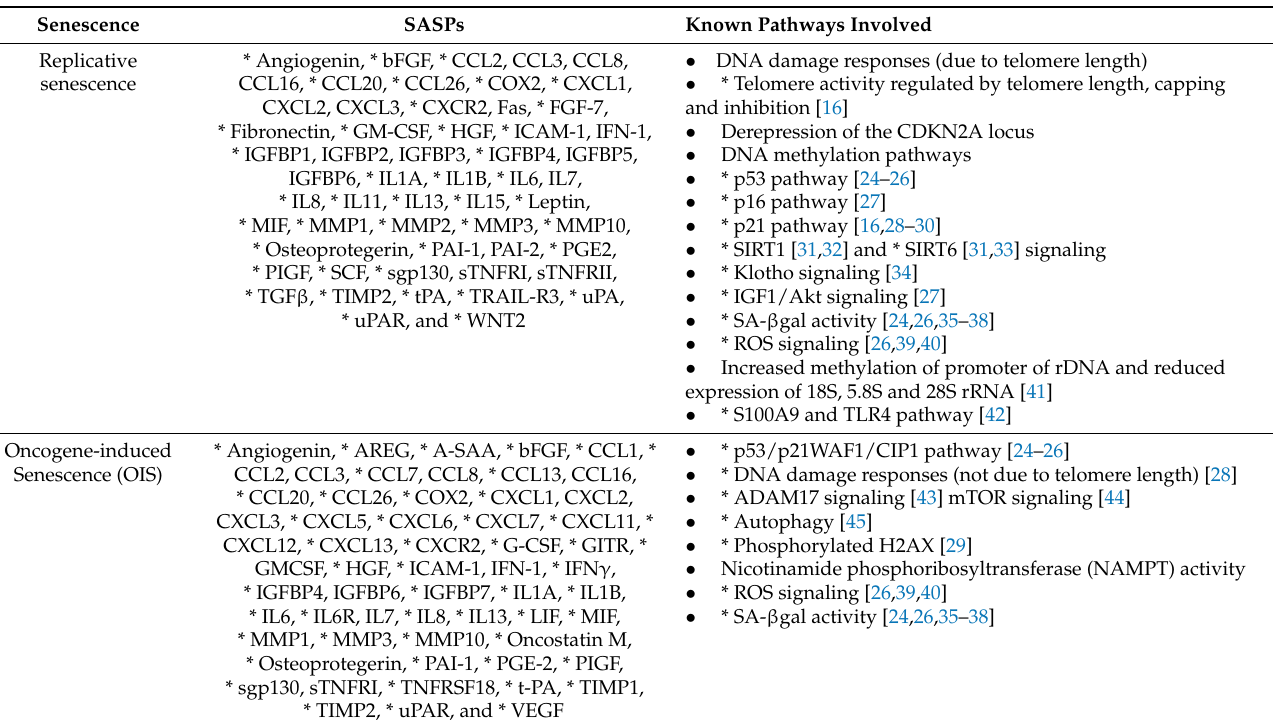
Table 1. Summary of the different types of senescence and